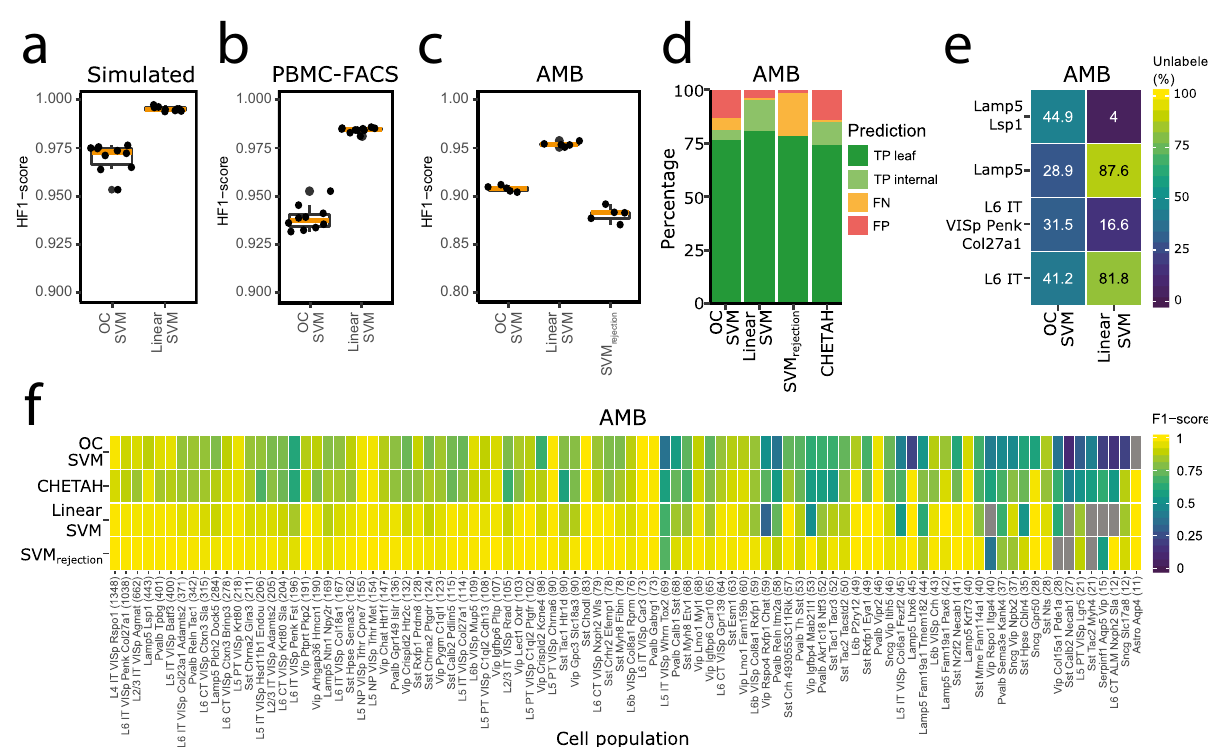
Fig. 3 Classi fi cation performance. a – c Boxplots showing the HF1-score of the one-class and linear SVM during n -fold cross-validation on the a simulated ( n = 10), b PBMC-FACS ( n = 10), and c AMB ( n = 5) dataset. In the boxplots, the middle (orange) line represents the median, the lower and upper hinge represents the fi rst and third quartiles, and the lower and upper whiskers represent the values no further than 1.5 interquartile range away from the lower and upper hinge, respectively. d Barplot showing the percentage of true positives (TP), false negatives (FN), and false positives (FP) per classi fi er on the AMB dataset. For the TPs a distinction is made between correctly predicted leaf nodes and internal nodes. e Heatmap showing the percentage of unlabeled cells per classi fi er during the different rejection experiments. f Heatmap showing the F1-score per classi fi er per cell population on the AMB dataset. Gray indicates that a classi fi er never predicted a cell to be of that